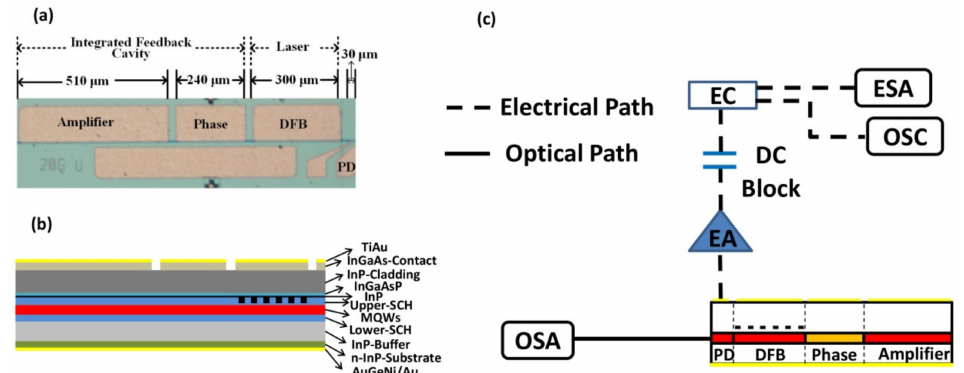
Figure 1. ( a ) Microscopic picture; ( b ) schematic diagram; and ( c ) test system diagram of the integrated laser-photodetector chip. EA: electrical amplifier; EC: electrical coupler; OSA: optical Spectrum analyzer; OSC: oscilloscope; ESA: electrical spectrum